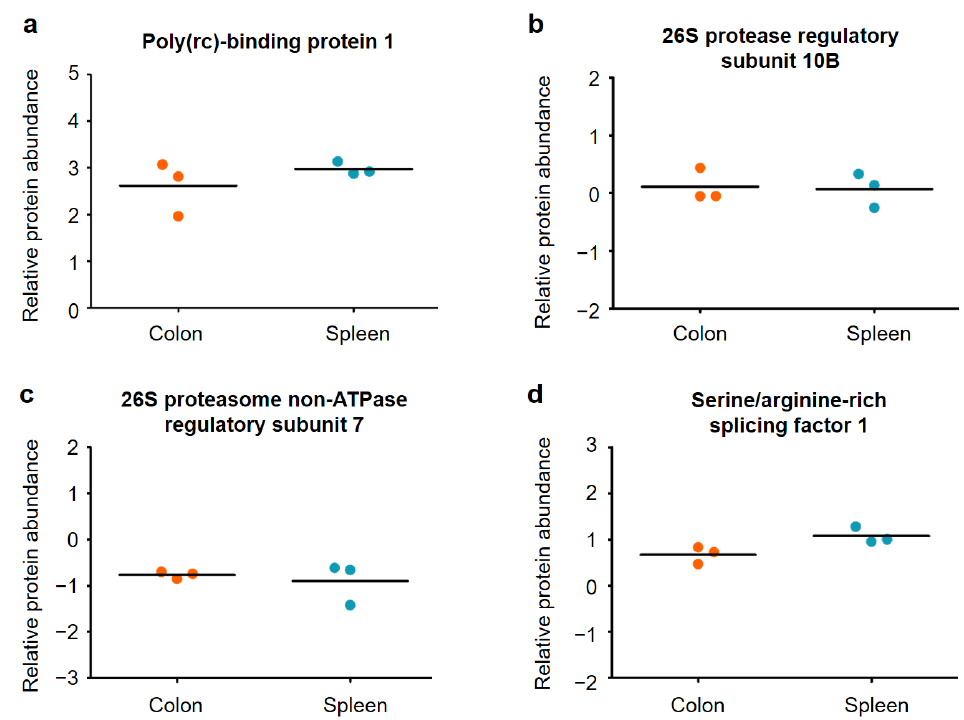
Figure 5. Relative protein abundance plots for ( a ) Poly(rC)-binding protein 1 (Pcbp1), ( b ) 26S protease regulatory subunit 10B (Psmc6), ( c ) 26S proteasome non-ATPase regulatory subunit 7 (Psmd7) and ( d ) Serine/arginine-rich splicing factor 1 (Srsf1) in murine colon and spleen samples. The data in ( a – d ) are highlighted in orange for colon tissue and in blue for spleen